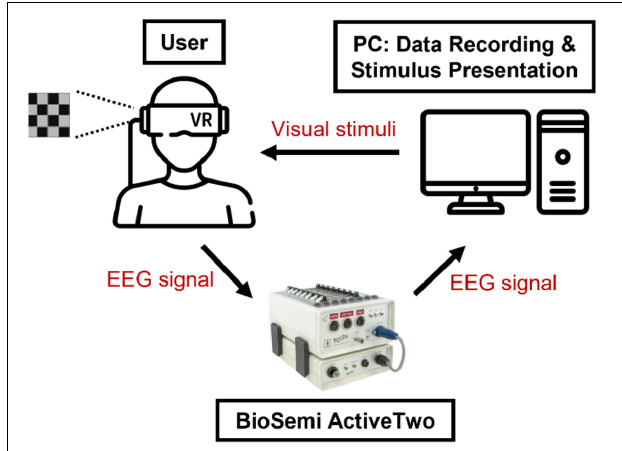
FIGURE 2 | A schematic diagram of the proposed hybrid BCI system. The visual stimuli were presented to the user via a VR-HMD, which was controlled by Unity software in a PC. The EEG signals were measured from a user by a biosignal amplifier (BioSemi